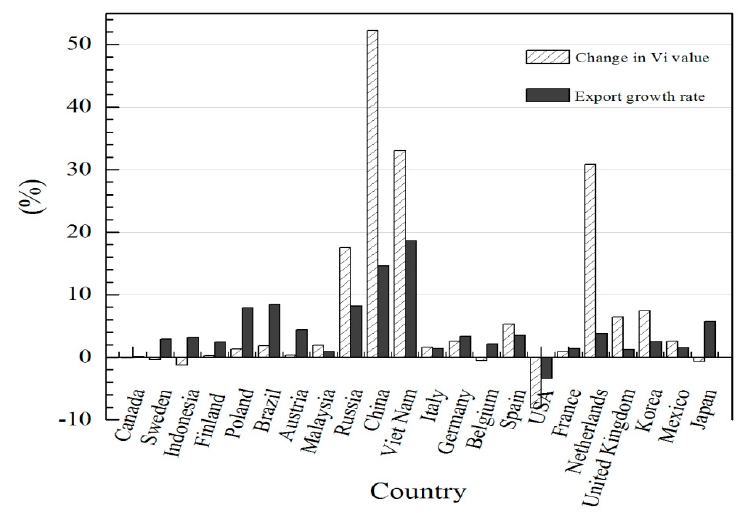
Figure 3. Changes in comprehensive international competitiveness index and export growth rate for selected countries.